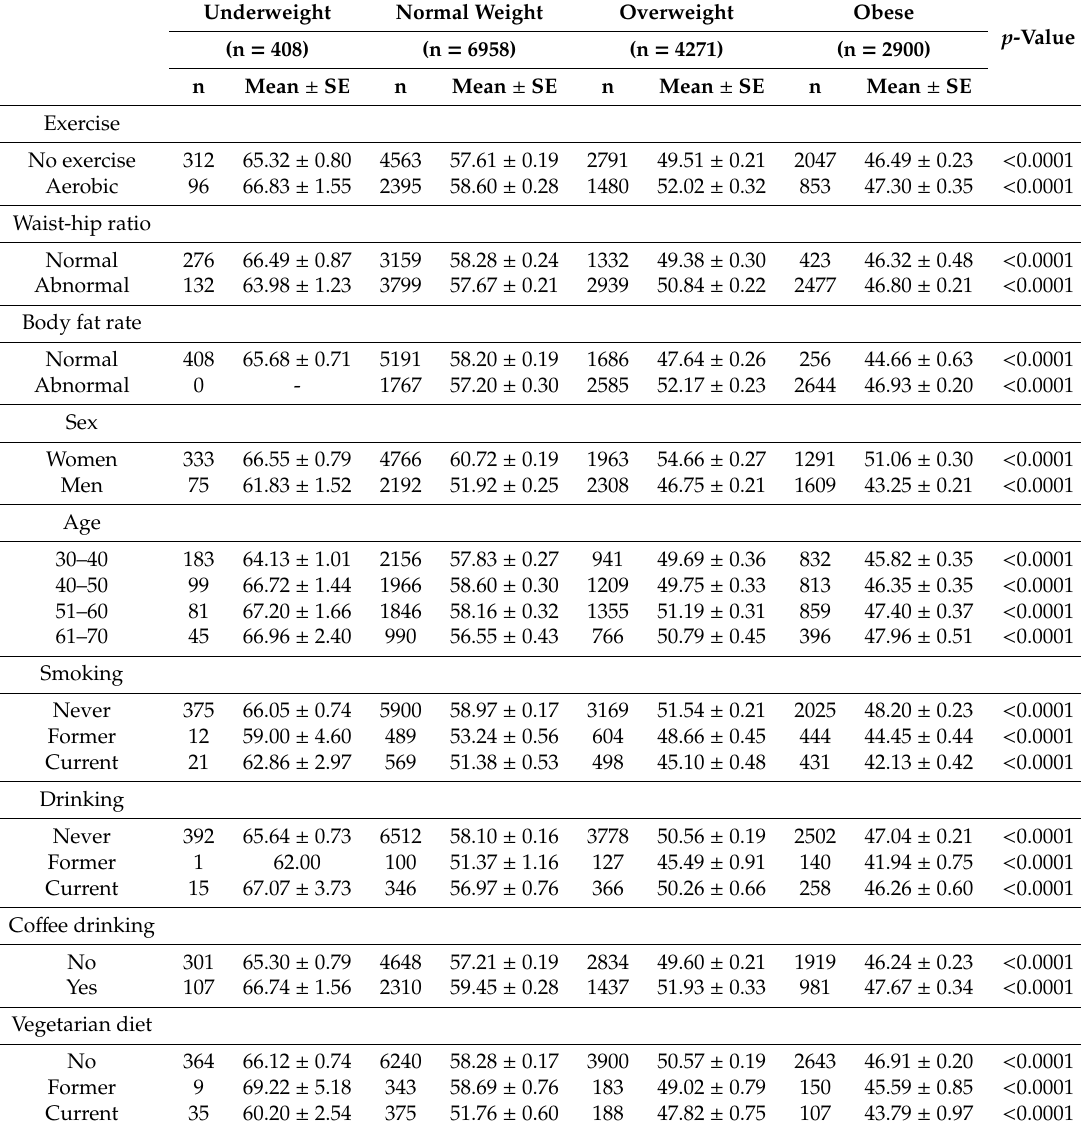
Table 2. Mean HDL-C levels of participants categorized by BMI. Underweight Normal Weight